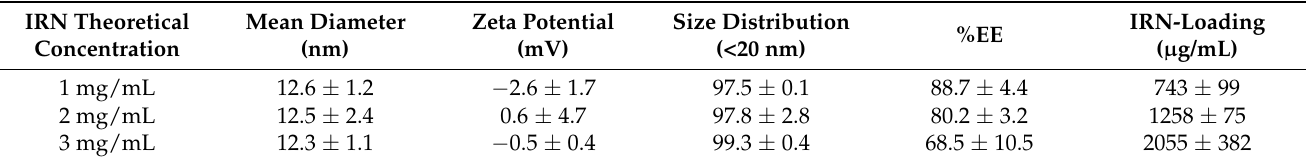
Table 2. Physicochemical properties after lyophilization and reconstitution with IRN solution at different concentrations.